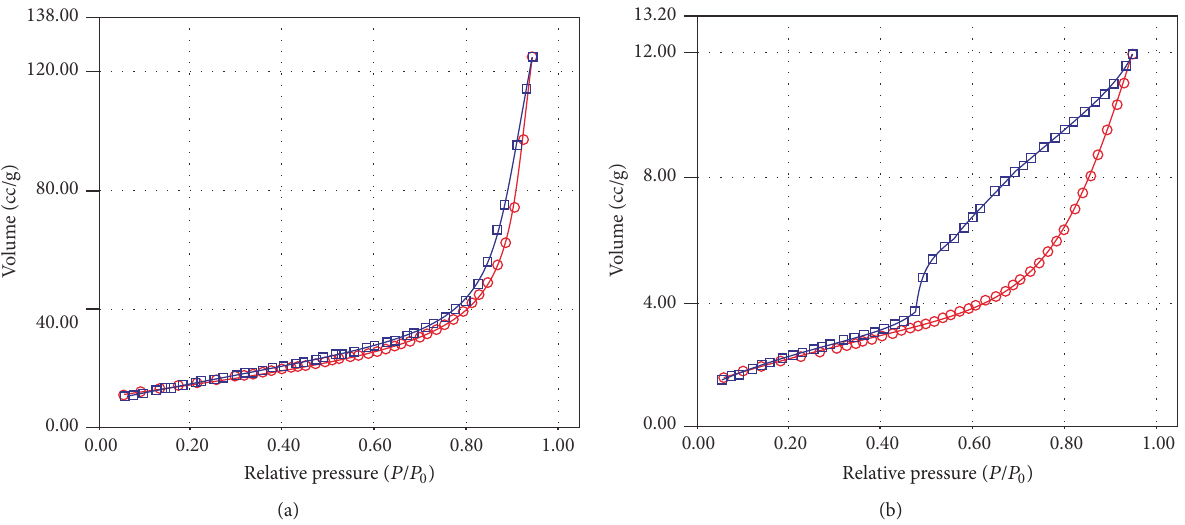
Figure 4: Nitrogen adsorption/desorption BET isotherms of the catalysts based on (a) hydrothermally treated and (b) coprecipitated layered double